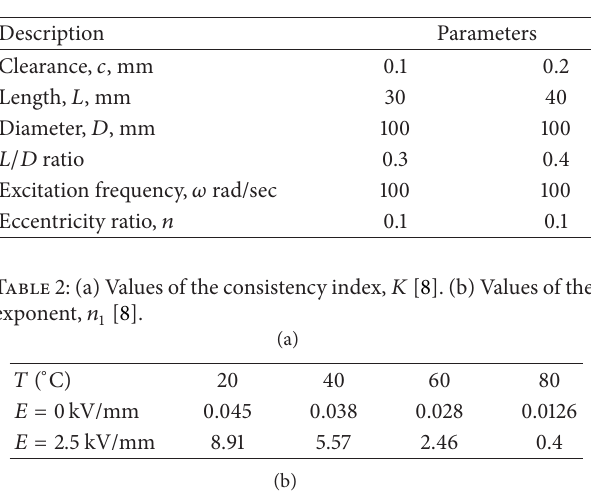
Table 1: Damper specifications.